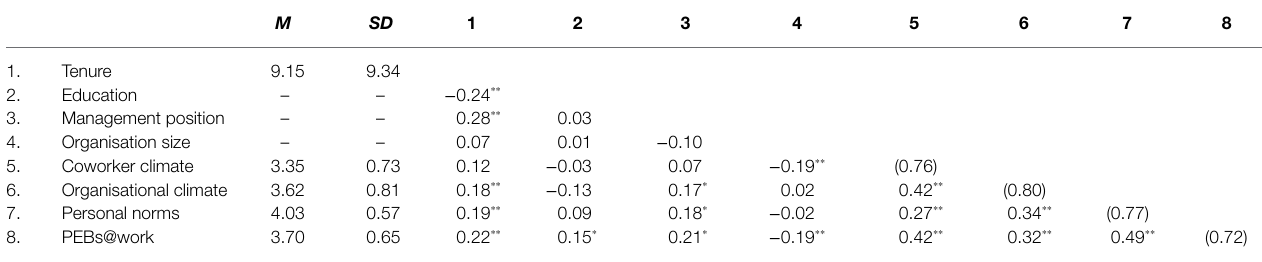
TABLE 1 | Descriptive statistics, correlations, and internal consistency for variables (number = 210).